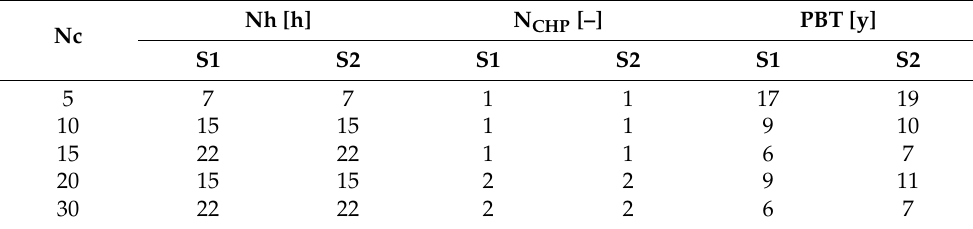
Table 10. Results of Nh, N CHP , and PBT values for Scenario 1 (S1) and Scenario 2 (S2).